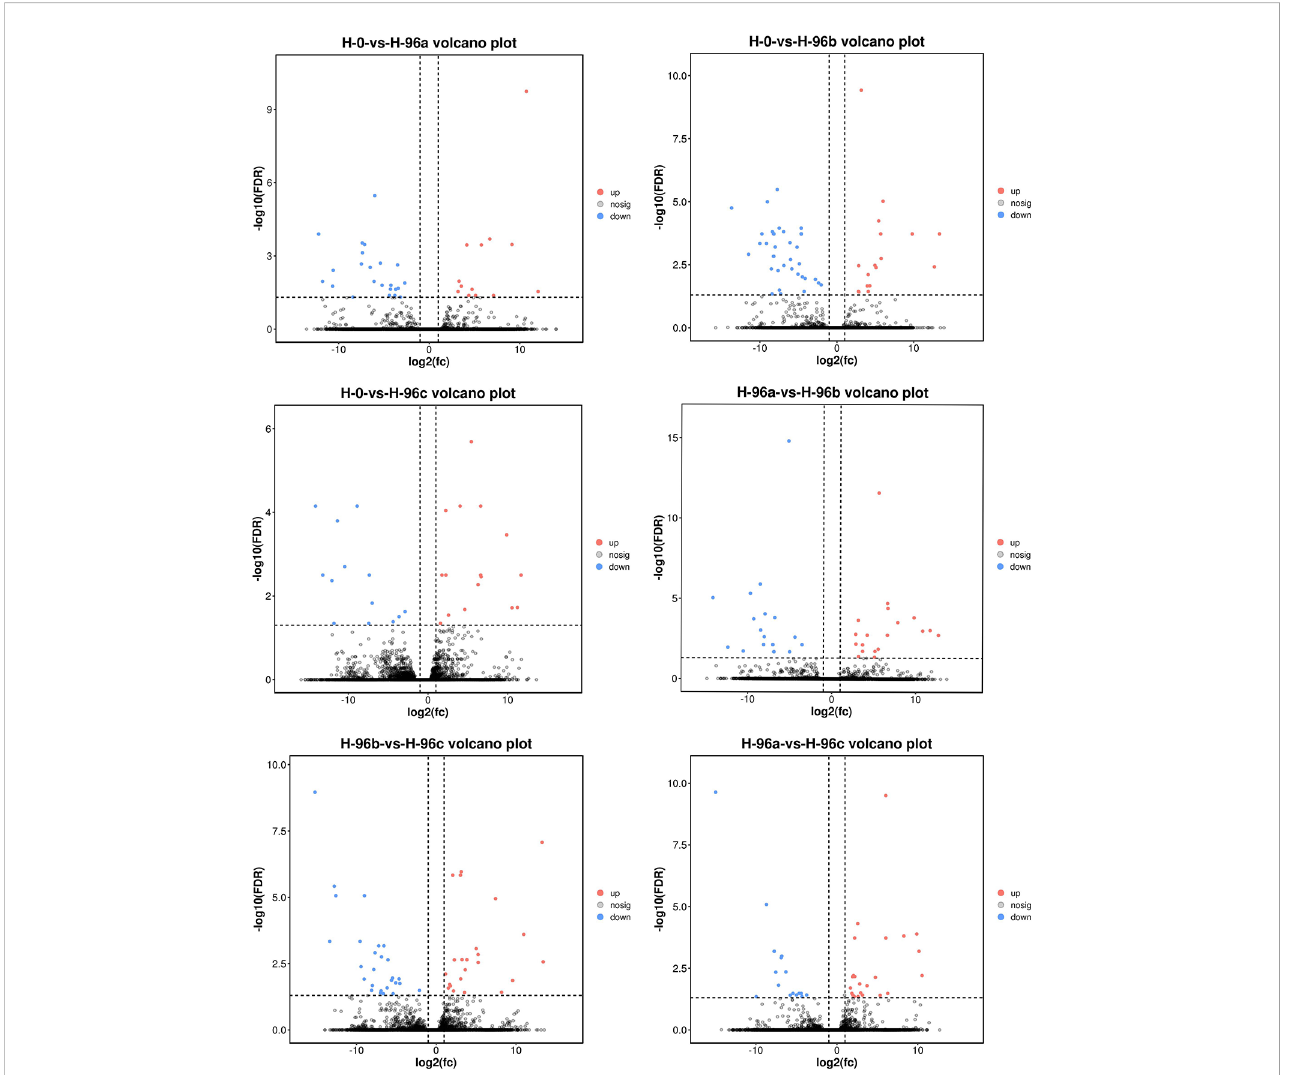
FIGURE 5 Difference comparison volcano map. H-0: Control group; H-96a: concentration of 20 mg/L group; H-96b: concentration of 50 mg/L group; H-96c: concentration of 100 mg/L group. Up- and down-regulated genes are shown in red and blue,